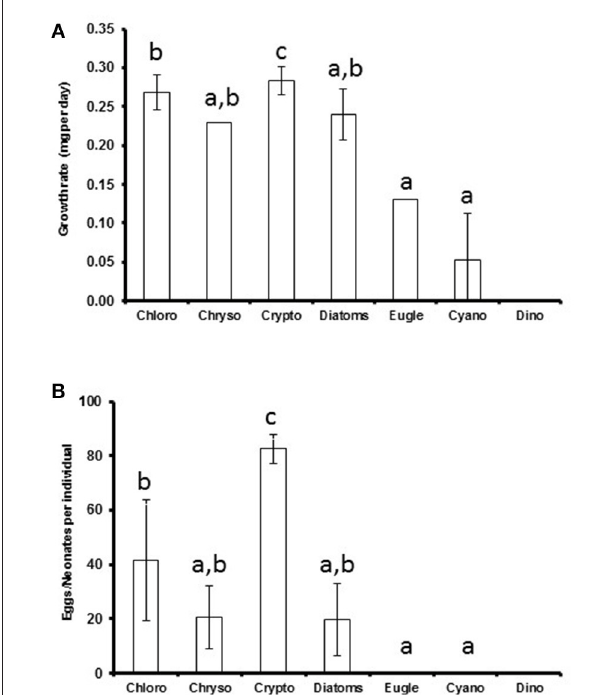
FIGURE 2 | The average phytoplankton class-specific growth rate (A) and clutch size (B) of Daphnia . Cryptophytes, rich in all studied biomolecules, could be classified as superior food for Daphnia in terms of both somatic growth and reproduction, whereas chlorophytes were high quality food, chrysophytes, and diatoms medium quality food and cyanobacteria, dinoflagellates, and euglenoids poor quality food. Different letters (a–c) denote significant differences ( p < 0.05) between diets. The error bars are for standard deviations.